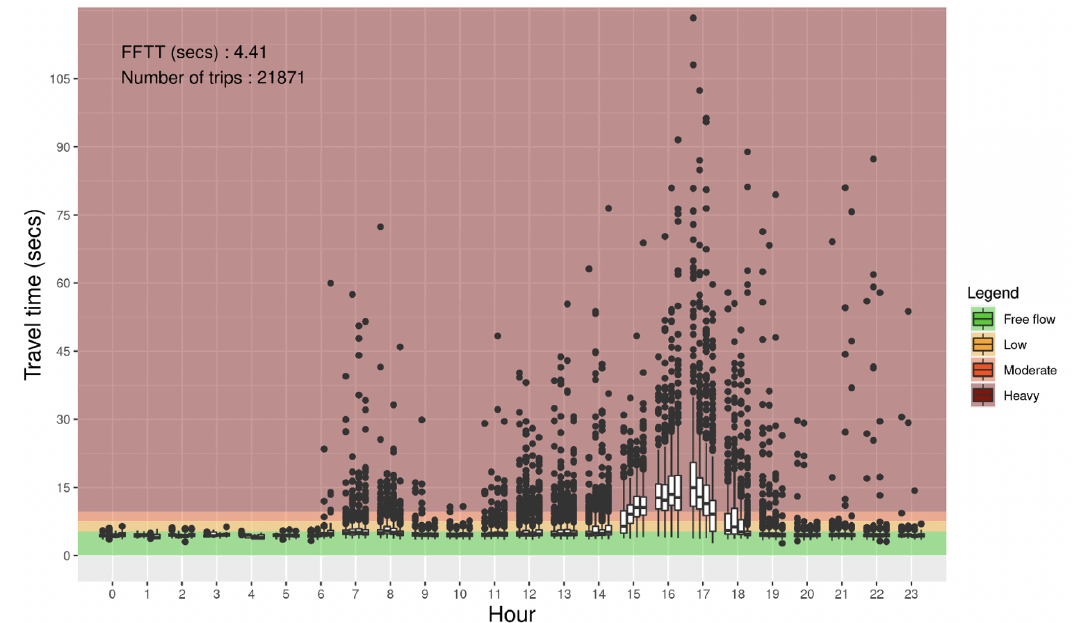
Figure 6. Travel time boxplots as a function of the time of the day with TTI classes observed on osm_id 283052776 (fraction start-end: 0.35–0.51) (Aut. Félix-Leclerc (40) east, Quebec